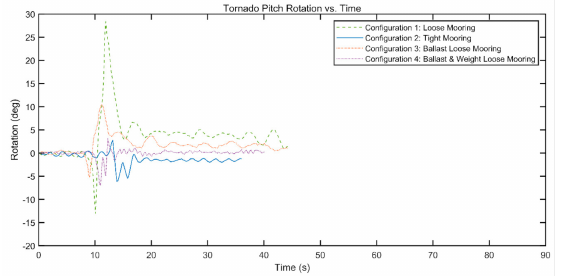
Figure A6. Tornado pitch rotations for all configurations.